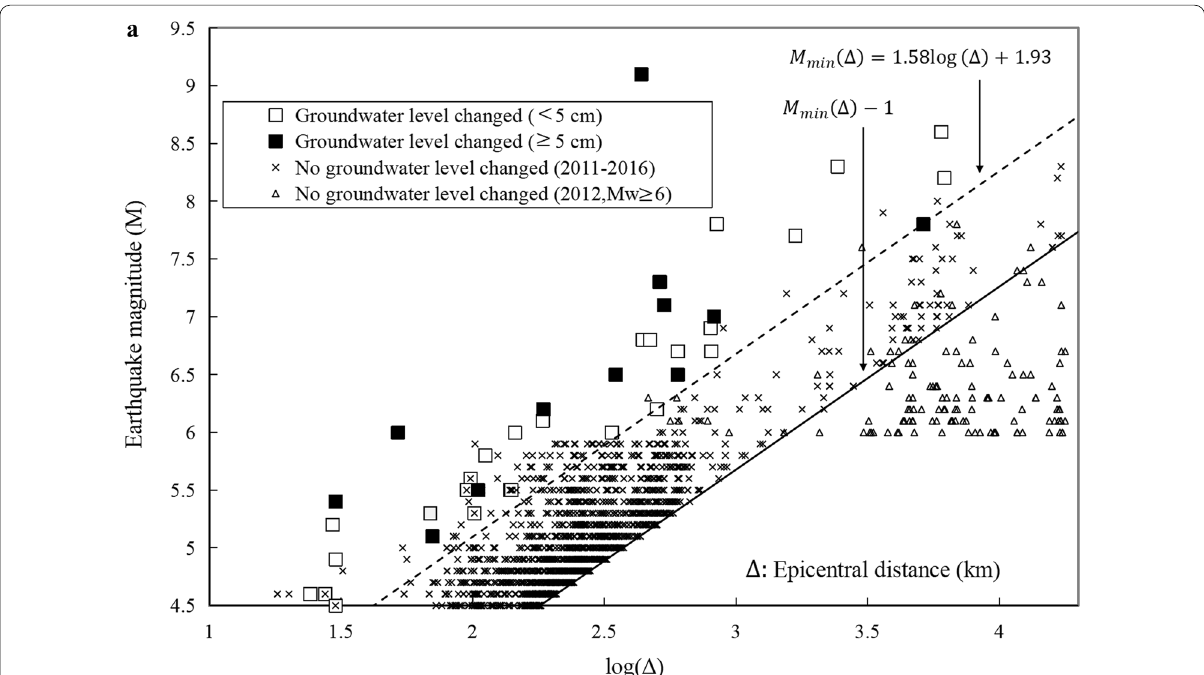
Fig. 3 Epicenters of the analyzed events and the examined events. a The magnitude–epicentral distance relation of groundwater level change in the Oi well. The broken line is the referenced magnitude–epicentral distance line which indicates the minimum magnitude for the groundwater level change in Oi well in 2012. The straight line is the basic line, for earthquakes above which we checked the groundwater level in the Oi well from 2011 to 2016. The solid and open squares show the events which caused the groundwater level changes larger than or equal to 5 cm in the Oi well and those less than 5 cm, respectively. The open triangles show the events (Mw ≥ 6 ) in2012, which we examined and found no groundwater level change in the Oi well. The crosses show the events, which we examined and found no groundwater level change in the Oi well for the period from 2011 to 2016. b The circles indicate the epicenters of the analyzed events. The number in the circle indicates the event number in Table 2. The plus marks show the events from 2011 to 2016, which accompany no groundwater level change or the groundwater level change less than 5 cm. The top figure shows the global map, and the bottom figure shows the area around